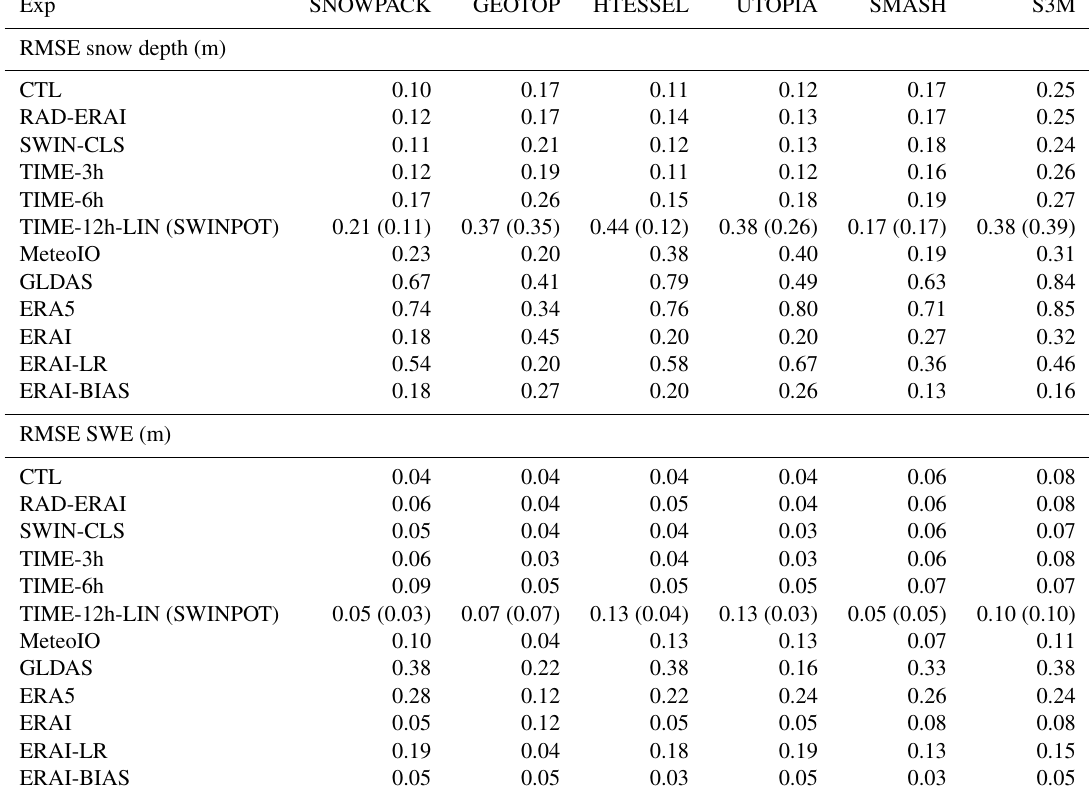
Table 4. RMSE values associated with snow depth and snow water equivalent simulations for all models and all experiments over the periods 2012–2017 and 2016–2017